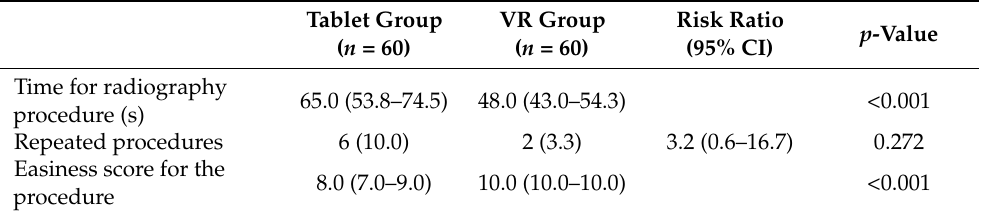
Table 3. Total procedure time, the number of repeated procedure and easiness score during chest